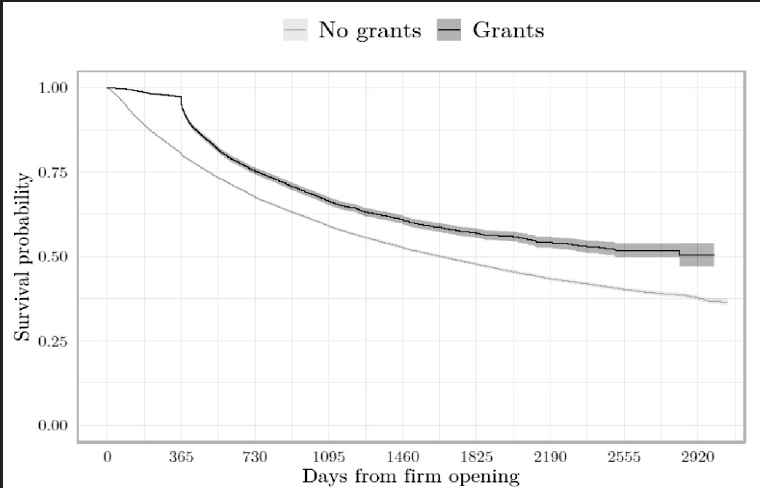
Kaplan–Meier firm survival